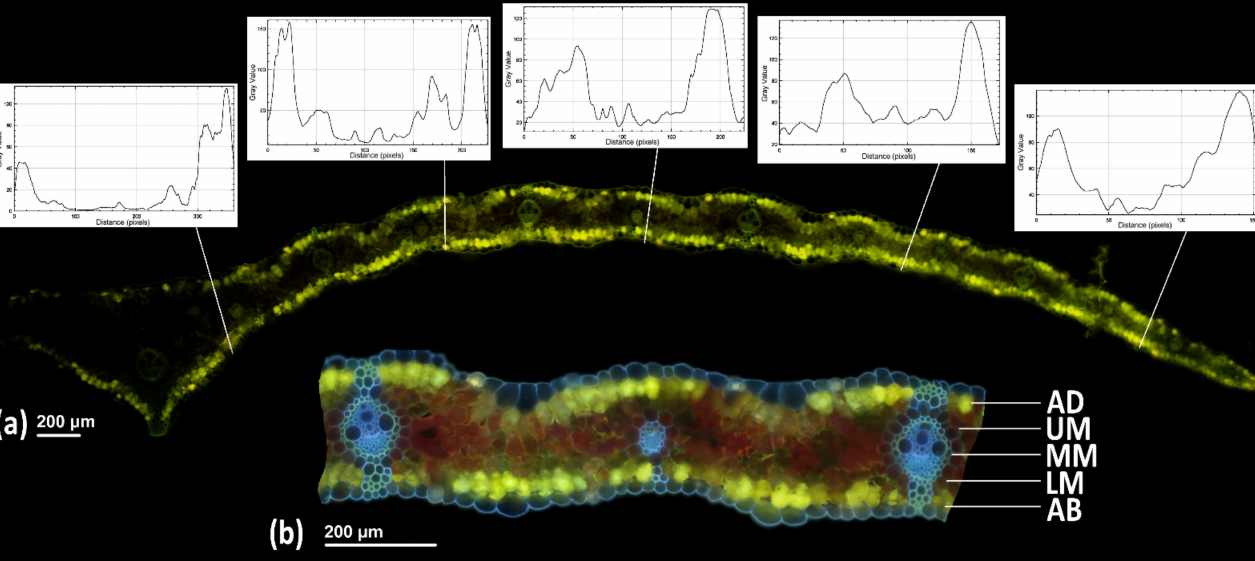
Figure 1. Method for quantitative measurements of relative intensities of PhC fluorescence throughout the mesophyll tissue inside half of a Hordeum vulgare leaf lamina using LinSys Cycloides and Plot Profile function in ImageJ. The plugin LinSys Cycloides automatically generates equally spaced lines over the image to provide systematic random sampling sites. ( a ) Straight line and Plot Profile tools are used to measure the intensity of pixel brightness at the sampling sites throughout the image of leaf PhC fluorescence (5 white graphs). ( b ) Pixel values of sample lines are divided into 5 segmental sections corresponding to 5 mesophyll depths: adaxial layer of mesophyll adjacent adaxial epidermis (AD), upper mesophyll (UM), middle mesophyll (MM), lower mesophyll (LM), abaxial layer of mesophyll adjacent to abaxial epidermis